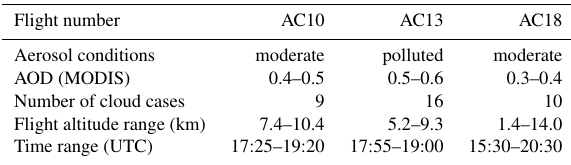
Table 1. Summary of presented flights with cloud-side observations during the ACRIDICON-CHUVA campaign. The ranges of flight altitude and time refer to the studied cloud